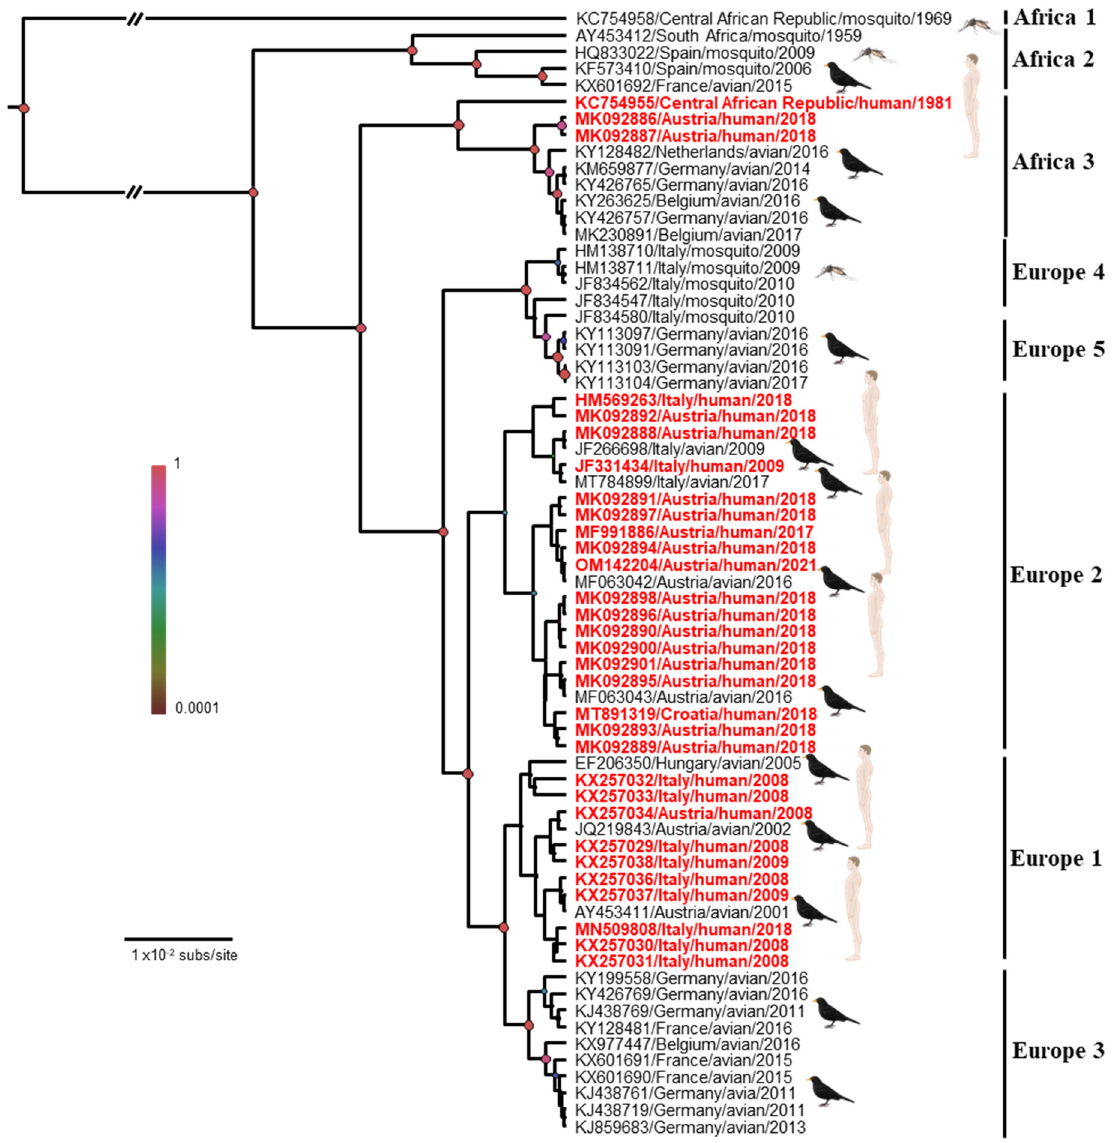
Figure 2. Bayesian maximum clade credibility tree representing the phylogenetic placement of the human Usutu virus cases (in red) compared with some representative USUVs based on partial NS5 gene sequences. Phylogenetic analysis was performed by using Bayesian Markov chain Monte Carlo (MCMC) tree-sampling method implemented in BEAST v.1.8.0 (http://beast.bio.ed.ac.uk, accessed on 20 November 2022). Statistical supports of grouping from Bayesian posterior probabilities (clade credibility) are indicated at the nodes (colored circles). GenBank accession numbers, countries of origin, host, and years of detection of the sequences used to reconstruct the tree are indicated on the branches. Scale bar indicates mean number of nucleotide substitutions per site. Edited with Bioren-der.com.